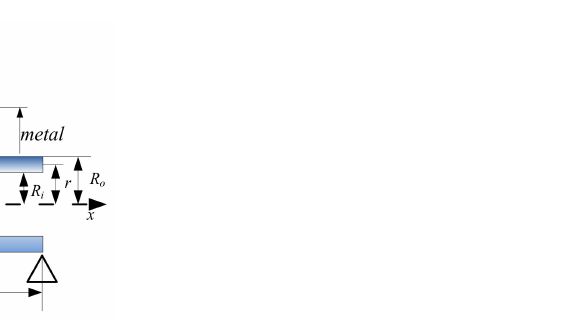
Figure 1. Structure diagram of functionally graded simply supported fluid-conveying